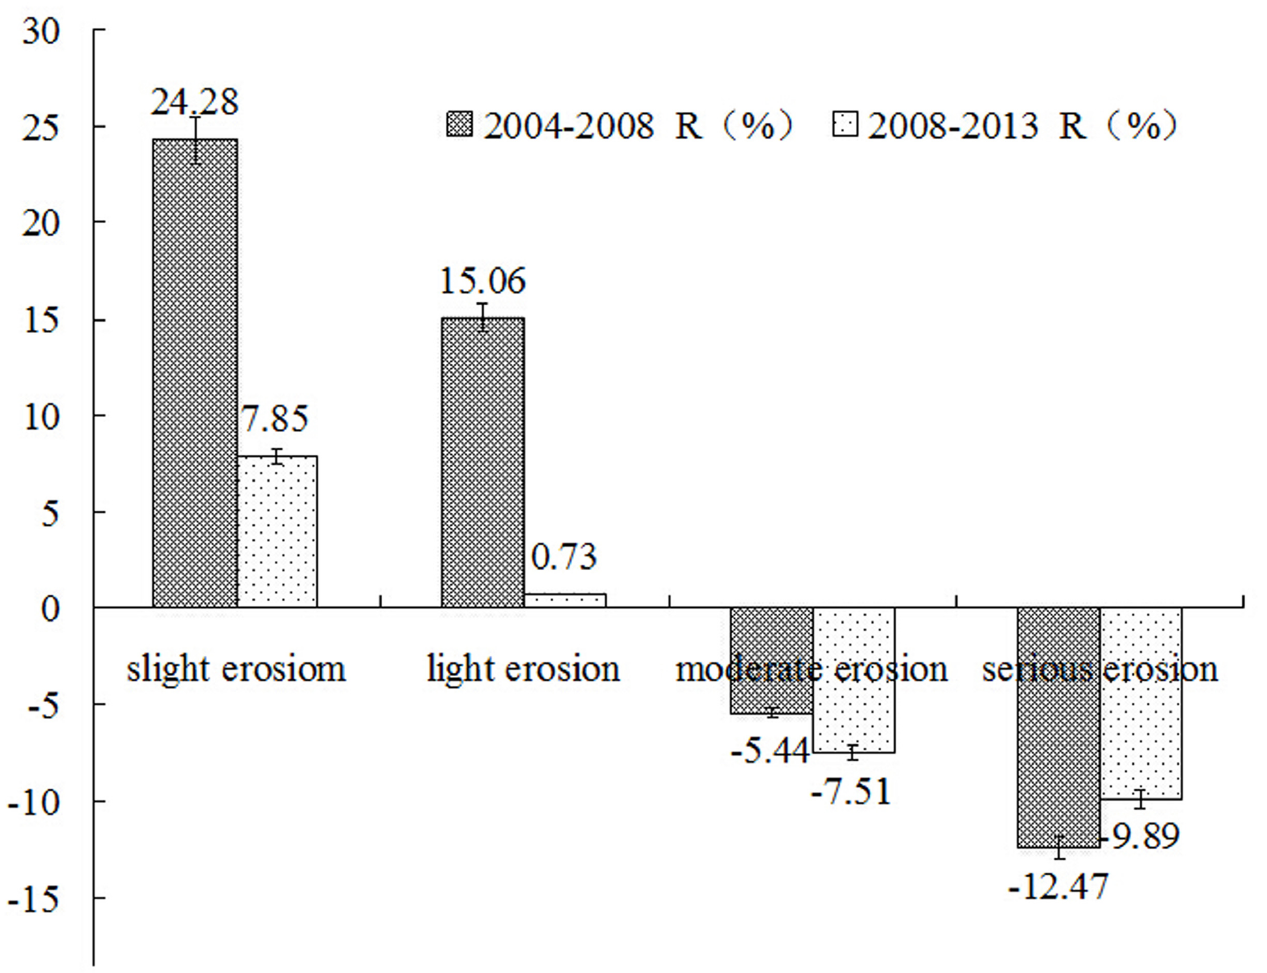
Fig 2. The change rate of soil erosion intensity of the ecological restoration area during different